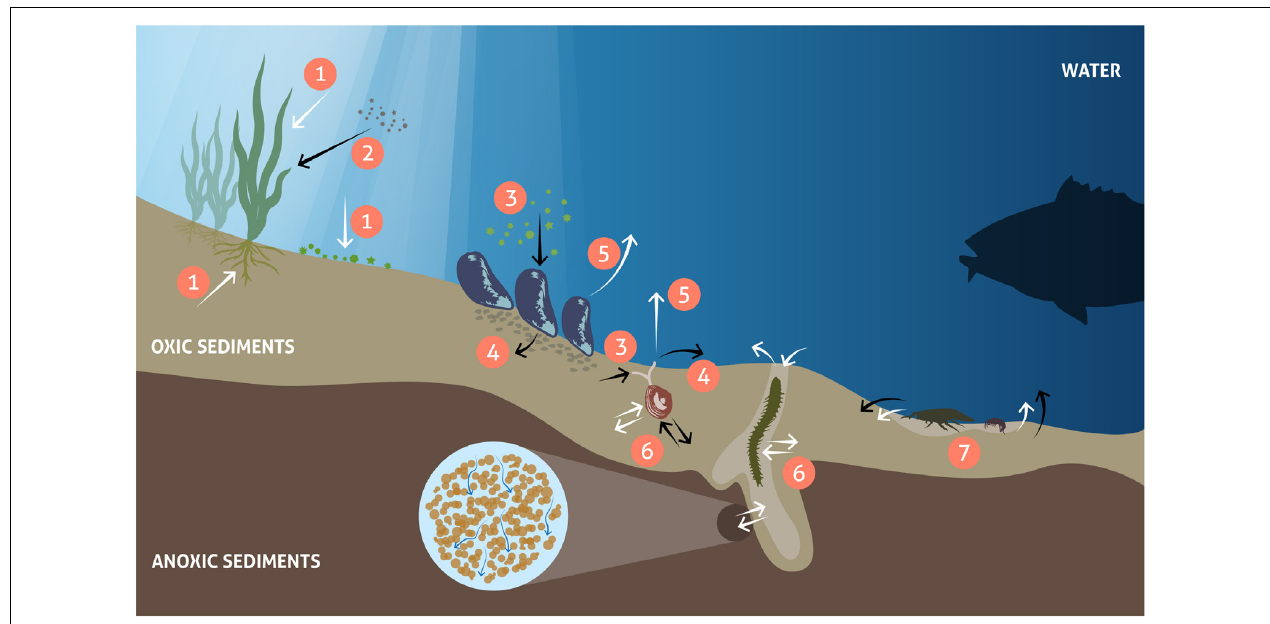
FIGURE 1 | Major processes related to vegetation and fauna controlling benthic biogeochemical fluxes. White arrows: solute fluxes, black arrows: particulate fluxes. Primary production: nutrient and CO 2 uptake and oxygen release (1), enhanced sedimentation and sediment stabilization by benthic primary producers (2), food uptake (3), egestion/biodeposition of feces (4), nutrient excretion and respiration (5), and bioturbation, including bioirrigation (6) and mixing of sediments